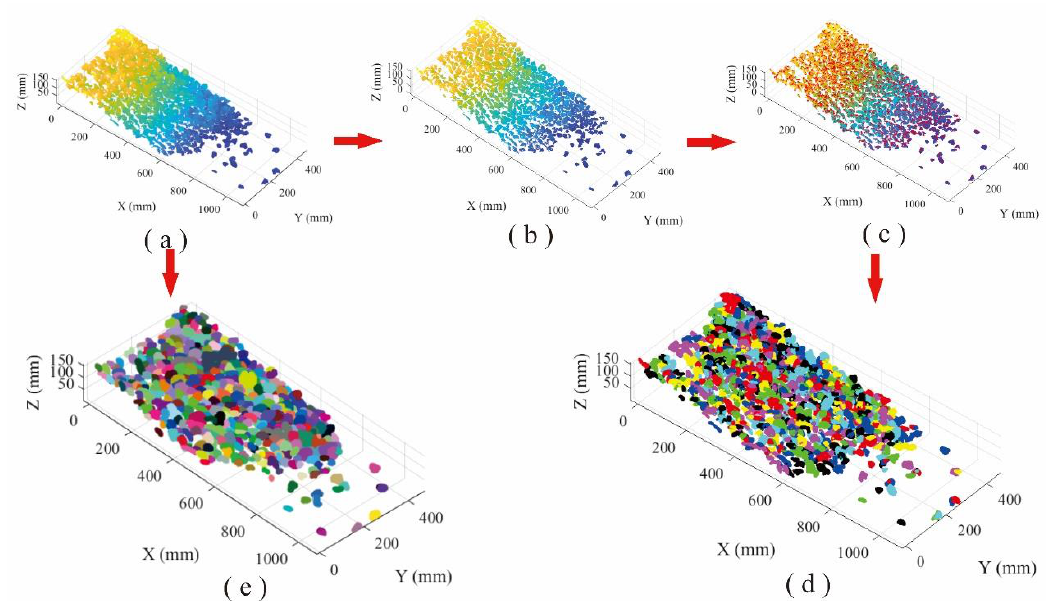
Figure 10. Comparison of recognition performance of gravel loose accumulation: ( a ) point cloud, ( b ) separation processing, ( c ) peak points of each block region, ( d ) recognition using HC-RG algorithm, and ( e ) recognition using AS algorithm.